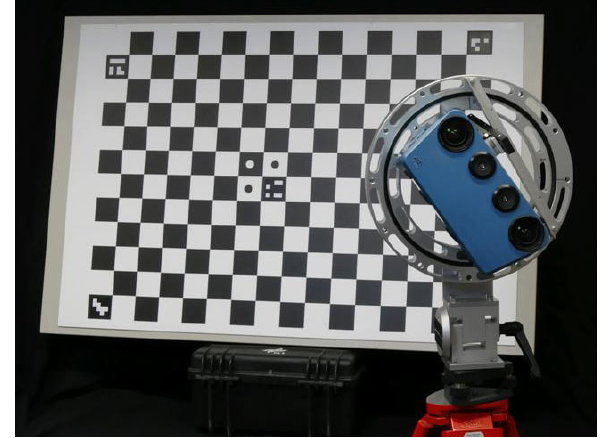
Figure 1: Background: Calibration board with AprilTags in the middle and the four corners as well as the three circles in the middle used for DLR Camera Calibration Toolbox. Foreground: DLR’s Integrated Positioning System with two cameras (outer) and two LEDs